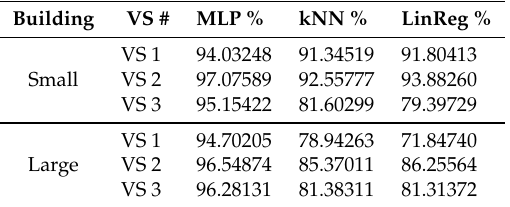
Table 2. Accuracy of the deployed virtual sensors vs state-of-the-art techniques.